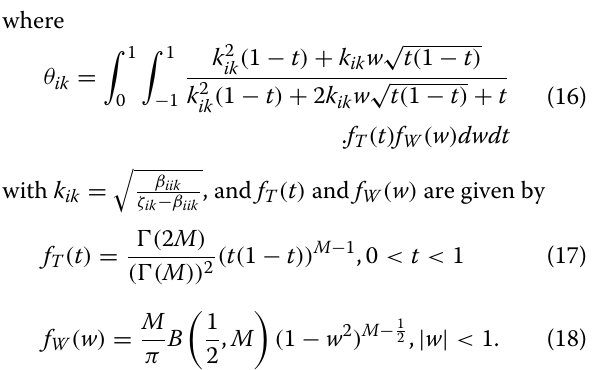
Figueiredo etal. EURASIPJournalonWirelessCommunicationsandNetworking (2018)